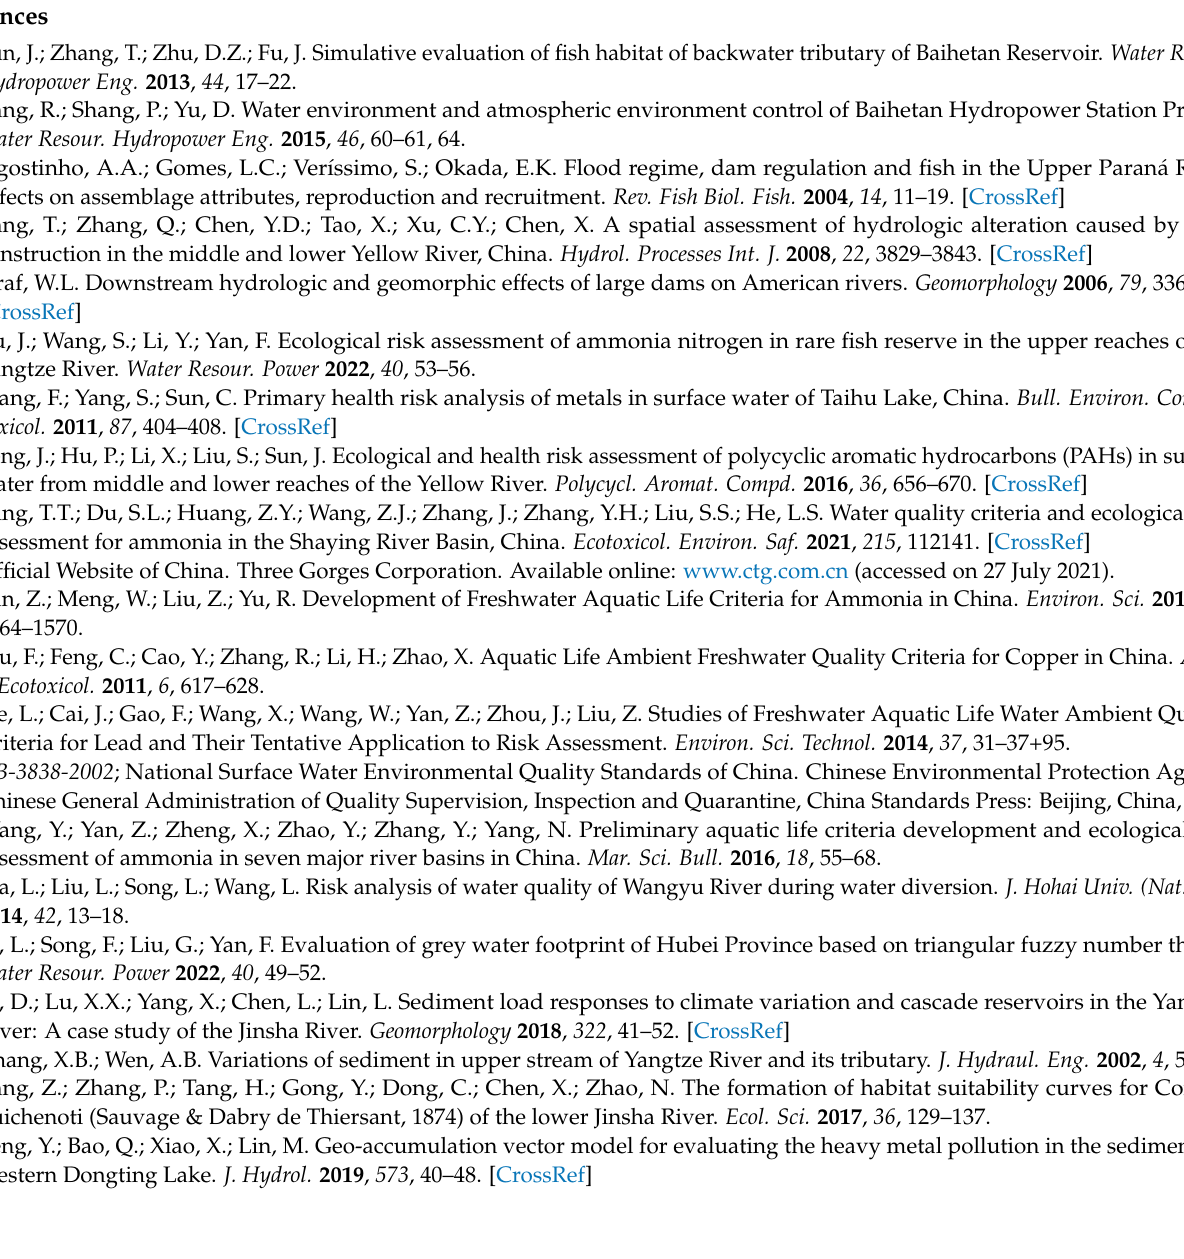
Table S2: Observation data after dam